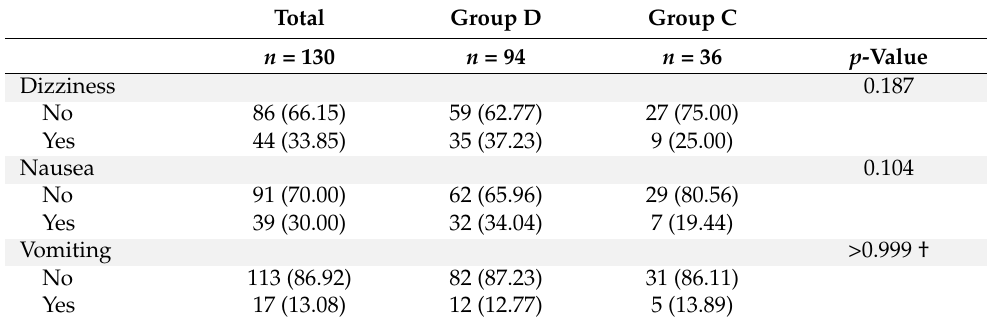
Table 5. Comparison of side effects between the